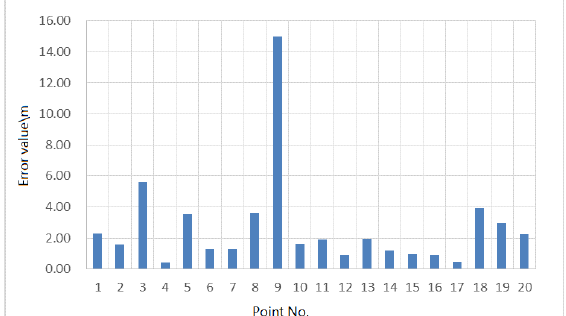
Figure 2. Distribution of plane accuracy